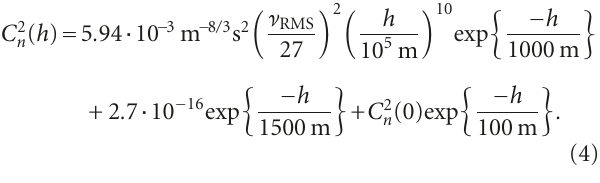
Figure 6(a) for the following three scenarios: (i) a GEO-to- HAP link with the HAP at h HAP = 20km and a receive tele- scope diameter of D = 0 . 135m, (ii) a GEO-to-HAP link with D = 0 . 135m and h HAP = 2400m, and (iii) a GEO-to-ground link with a telescope diameter D = 1m at an optical ground